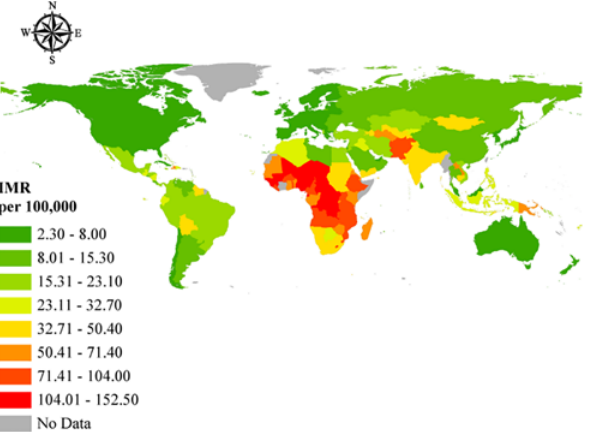
Fig 4. Geographic representation of the IMR. Open source polygon feature data for the maps were downloaded [20] and, subsequently, projected using ESRI ArcGIS [21].